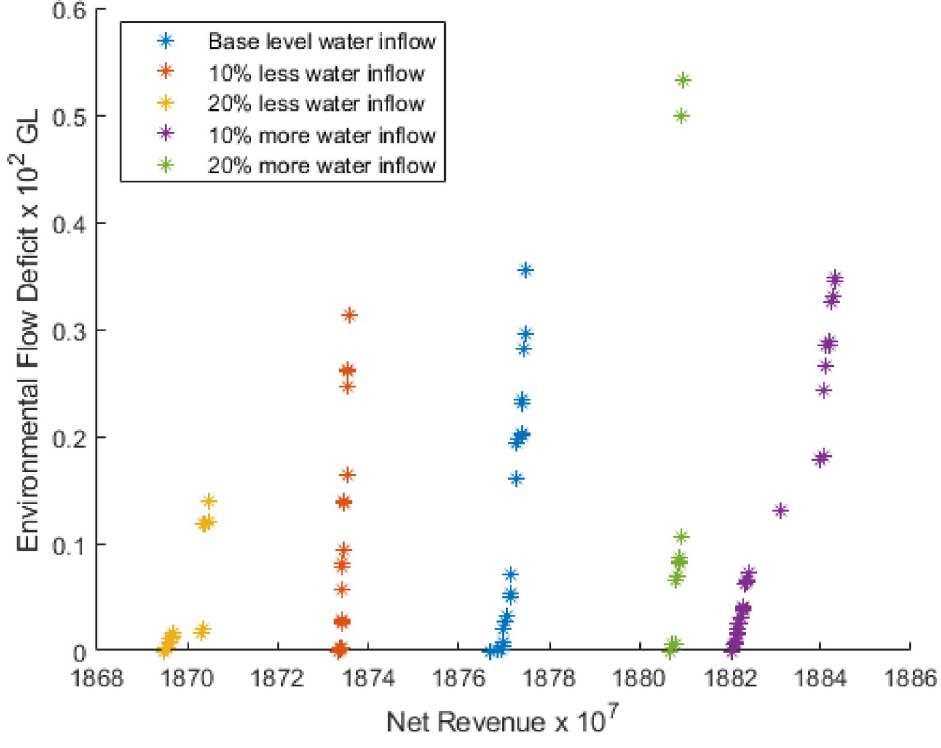
Fig 4. Pareto front for different water